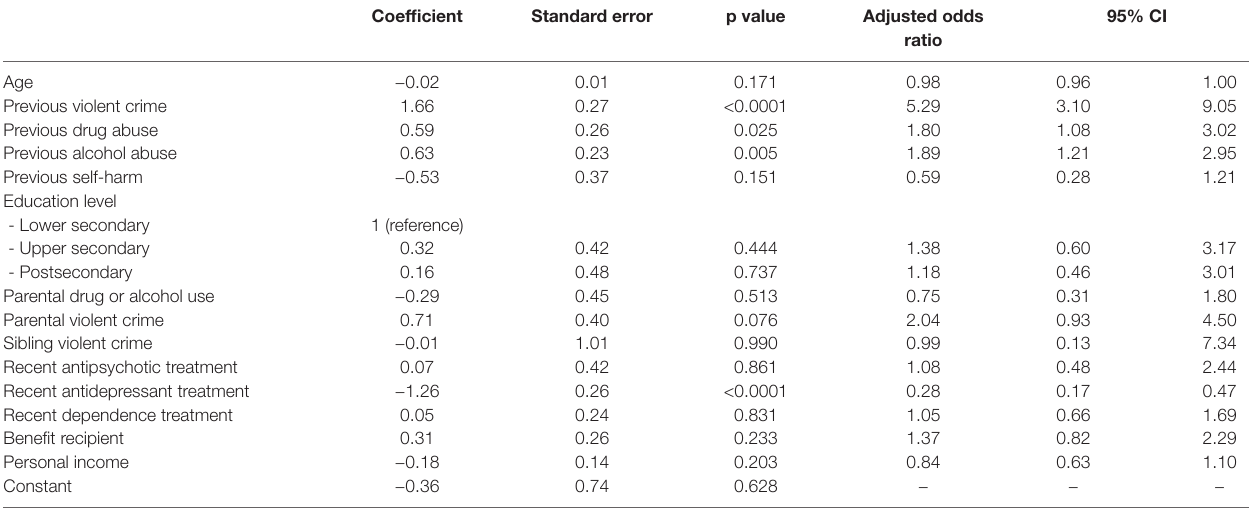
TABLE 3 | Association between risk factors and violent behavior from logistic regression after multiple imputation. Coefficient Standard error p value Adjusted odds